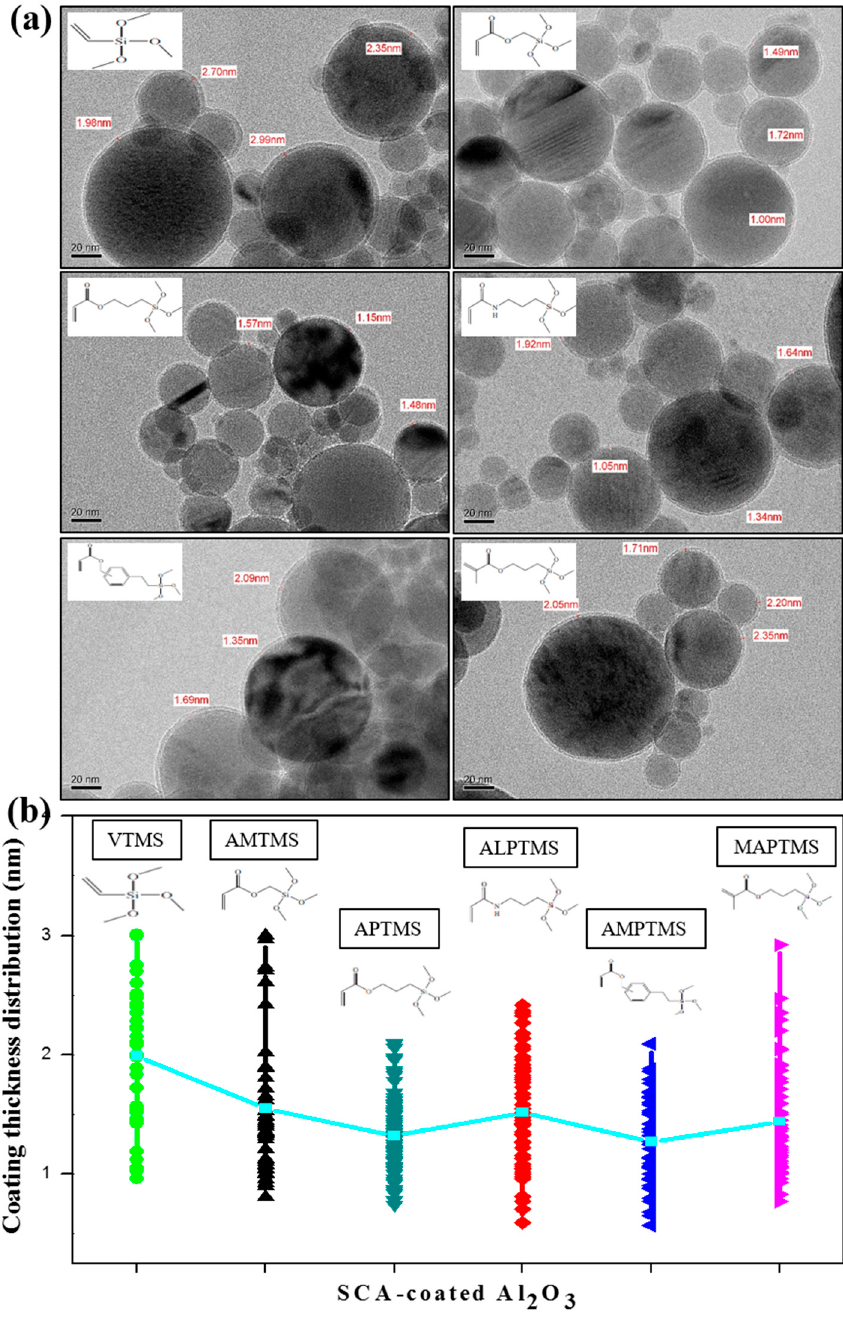
Figure 2. ( a ) TEM images and ( b ) the coating thickness distribution of the SCA-coated Al 2 O 3 ceramic particles with different organofuctional groups.